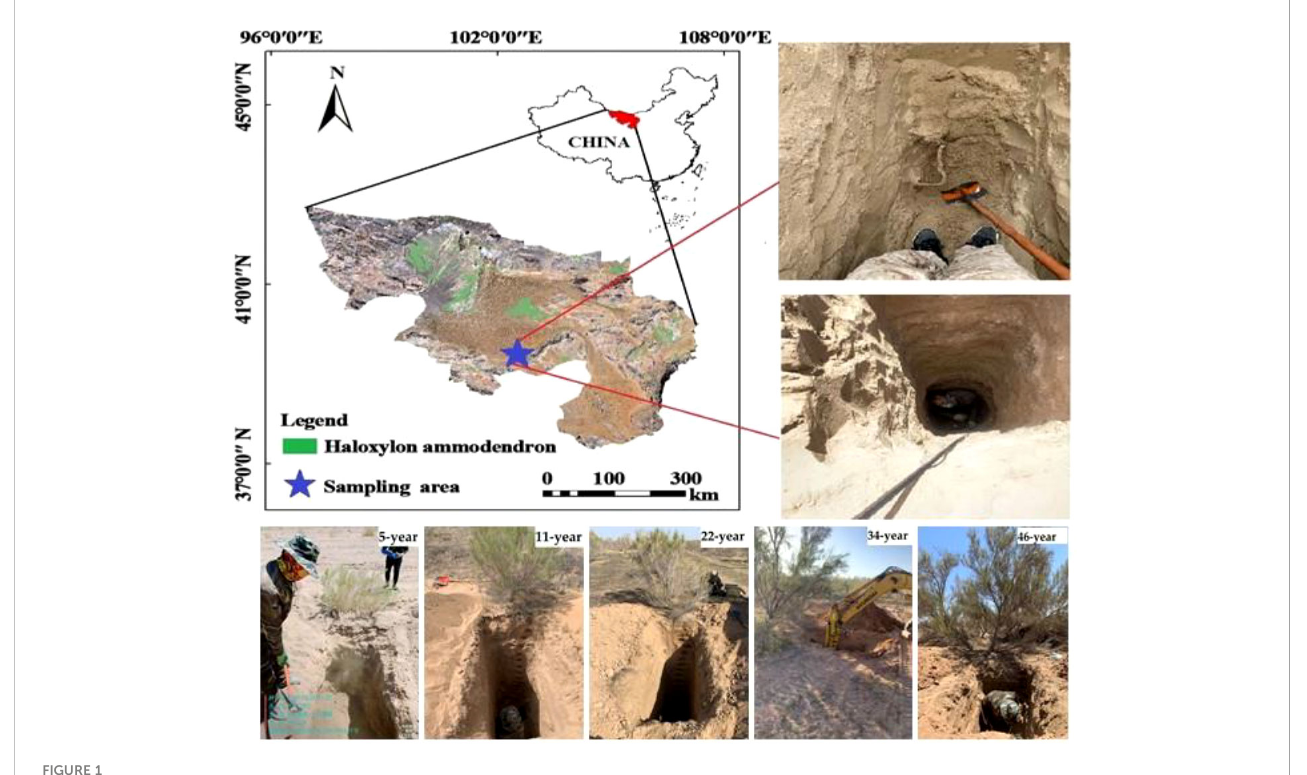
FIGURE 1 Location of the study